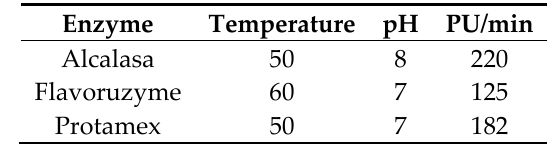
Table 1. Experimental proteolytic units (PU) and optimal temperature and pH for the hydrolysis of quinoa protein concentrate.